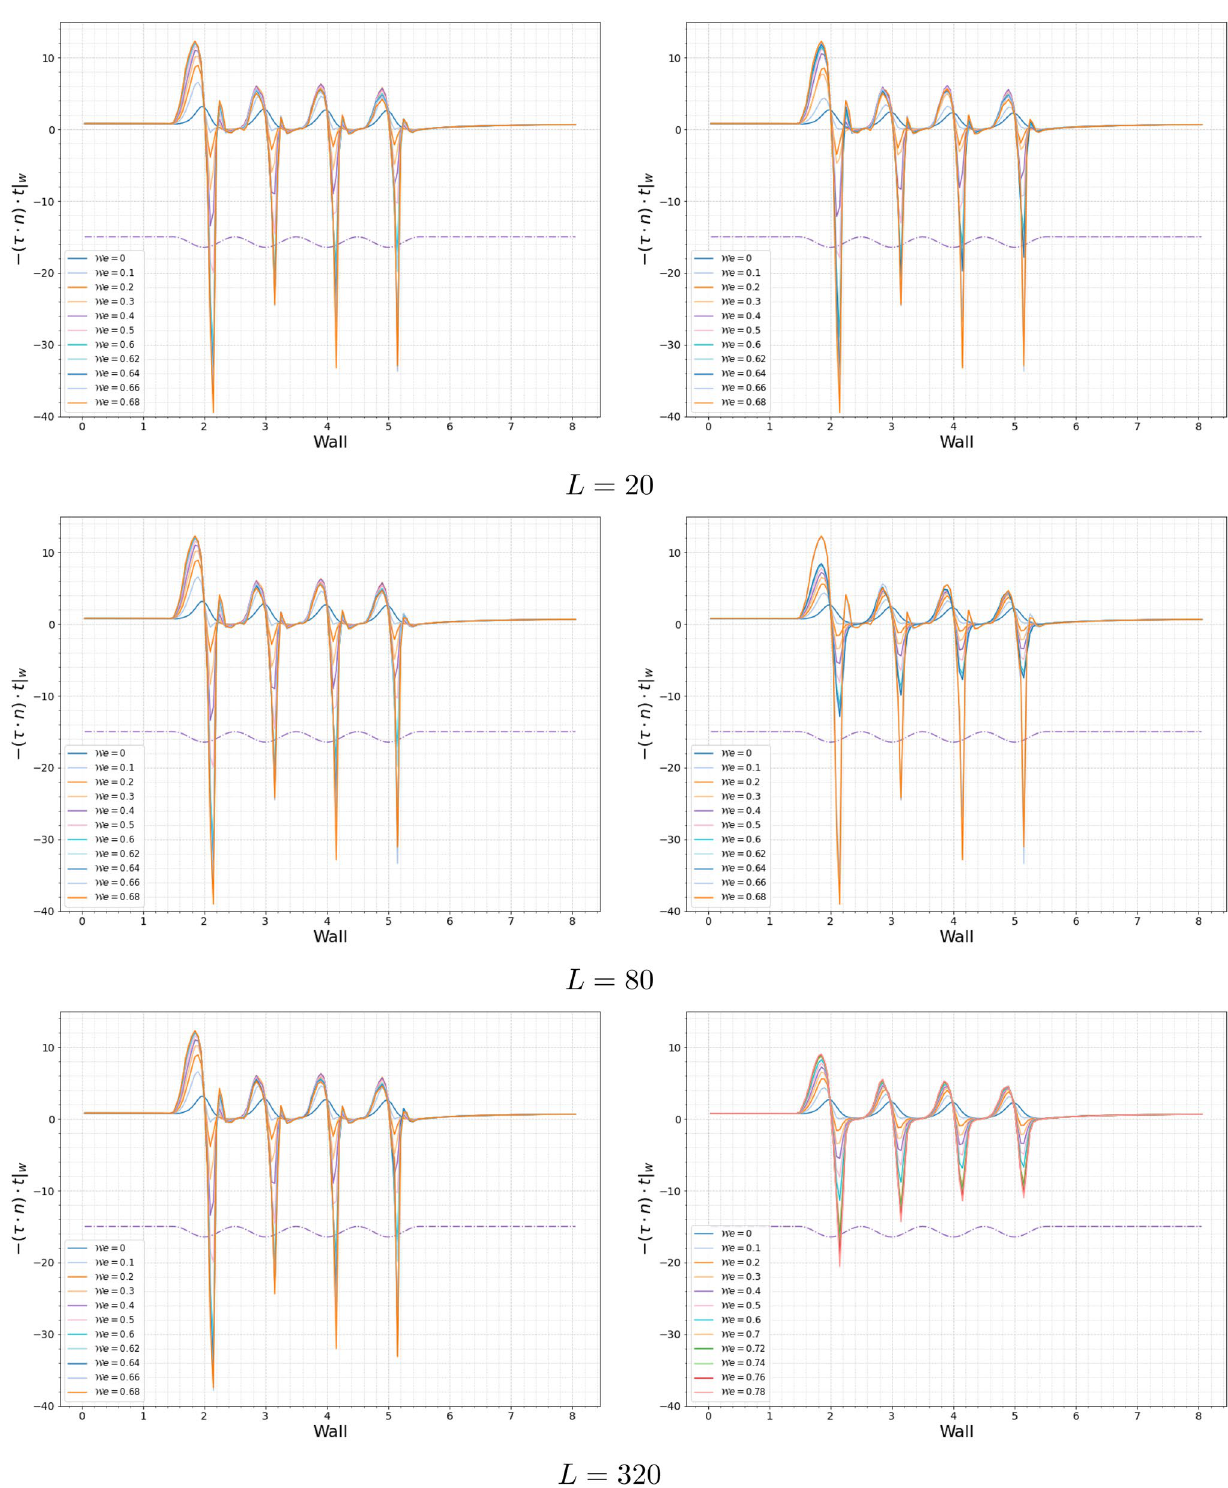
𝝉 ) (left) and 𝛼 ( ) (right) for differ- p t t ‖ ‖ ‖ ‖